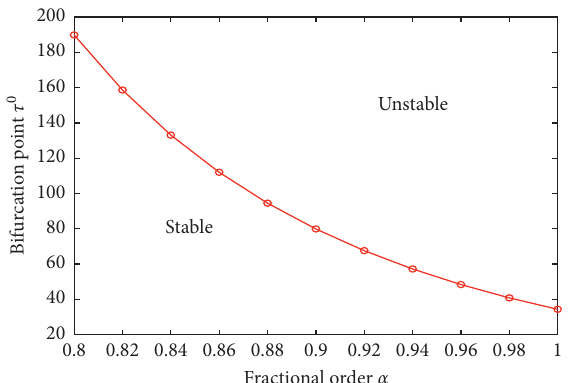
Figure 3: The impact of the fractional order α on the bifurcation value τ 0 for the uncontrolled system (3).